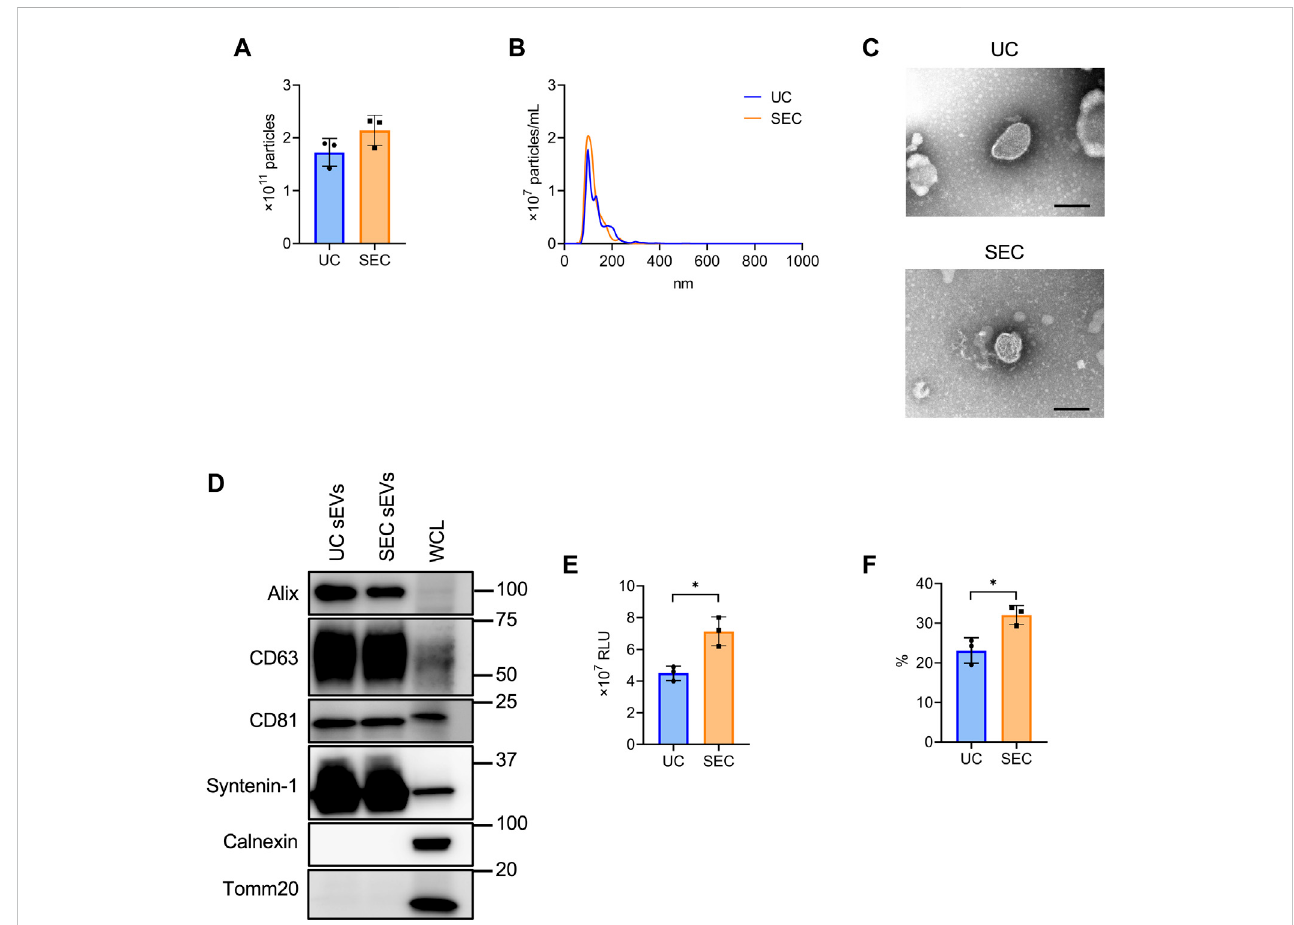
FIGURE 2 ThecomparisonofsEVcollectionbetweenUCandSEC. (A) ThenumberofparticlesinUCandSECsamples. (B) SizedistributionoftheparticlesinUCand SEC samples. (C) Transmission electron microscopic images of sEVs using UC and SEC. Scale bar, 100 nm. (D) Western blotting analysis of Alix, CD63, CD81, syntenin-1,calnexin,andtomm20expressioninHT29-CD63-NluccellsandsEVsusingUCandSECrecoverysystems.ThesEVmarkers,Alix,CD63,CD81,and syntenin-1; sEV negative protein markers, calnexin and tomm20. The protein content was 1.0 μ g for the sEV samples and 10 μ g for the whole cell lysate (WCL) samples. (E) The Nanoluc luciferase intensity of UC and SEC samples. (F) The recovery rate of the EVs collected using UC and SEC. The sample after concentration was calculated as 100%. * p -value < .05 by Student ’ s